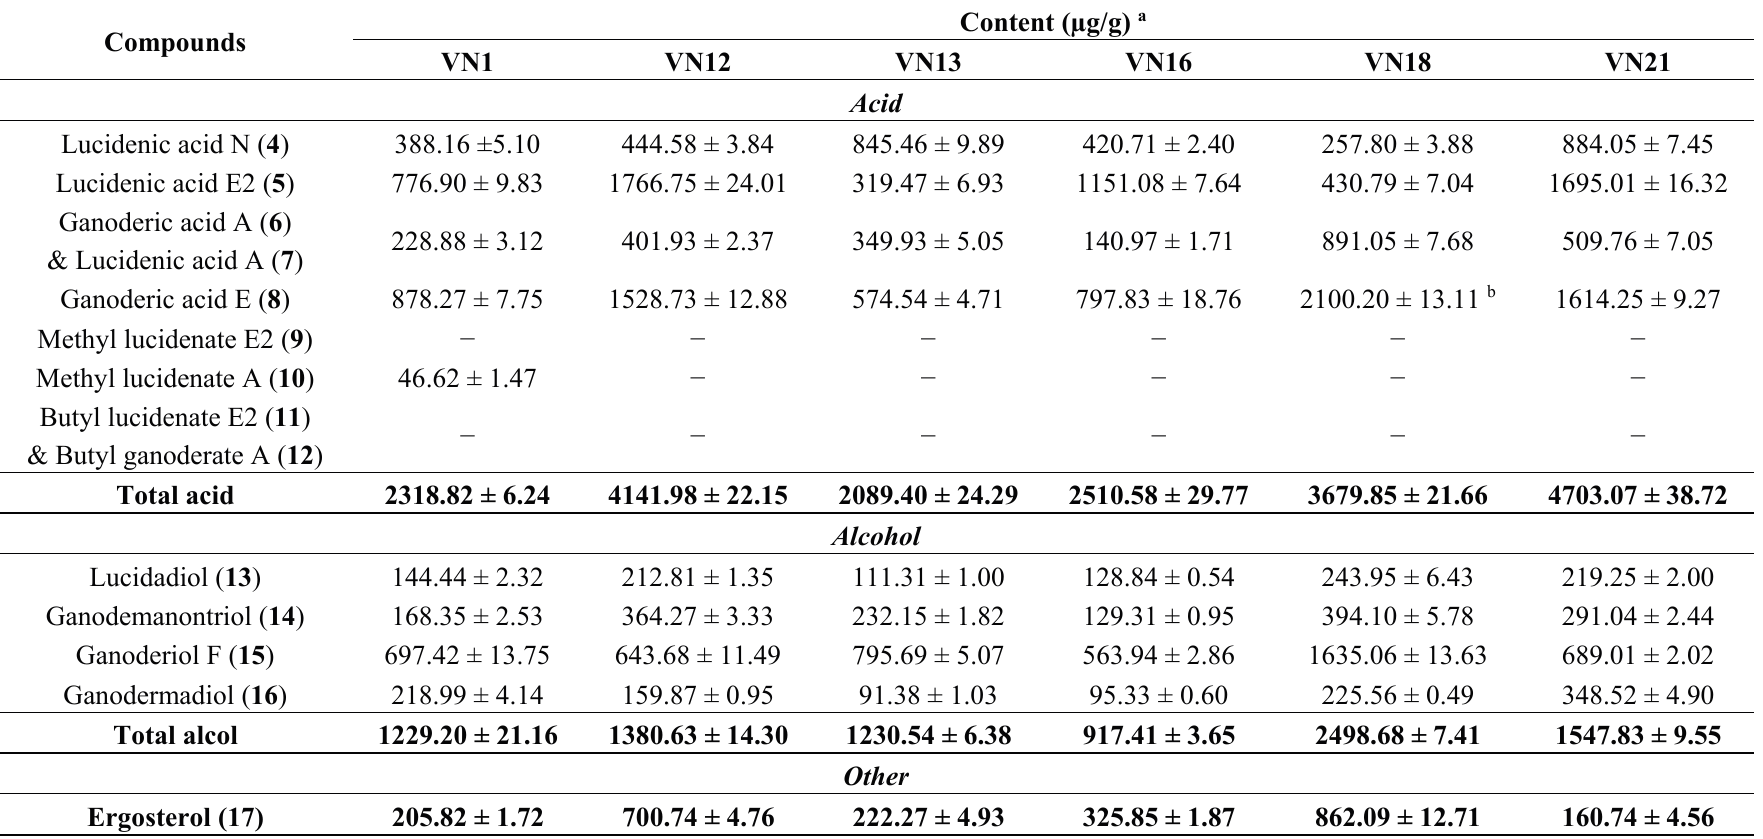
Table 4. Contents of 4 – 17 in the wild collected Linhzhi samples ( Group A